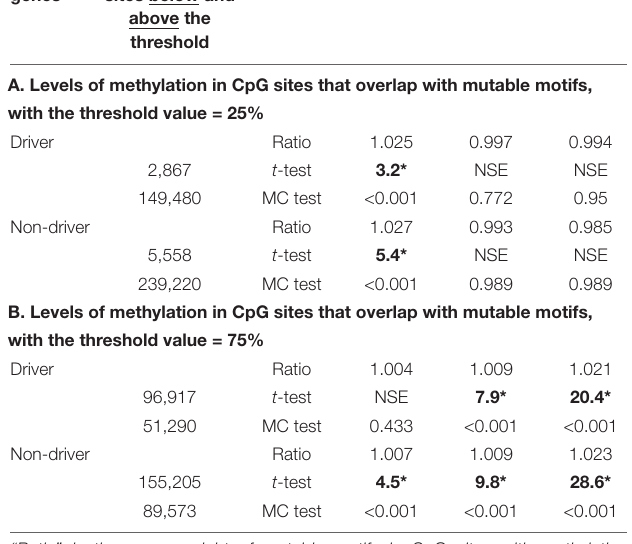
TABLE 3 | Analysis of methylation in CpG sites that overlap with pols η and θ mutable motifs. Group of Number of CpG genes sites below and